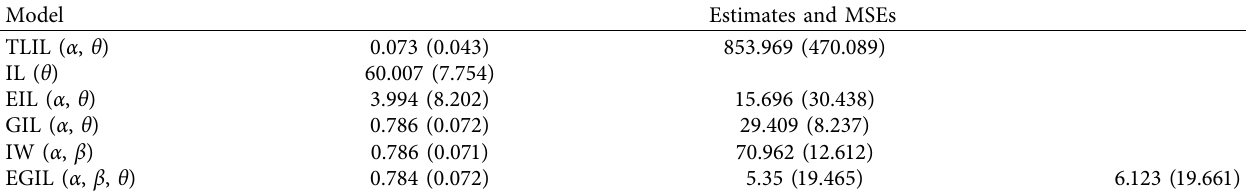
Table 7: Parameter estimates and the standard error in parentheses for dataset I.